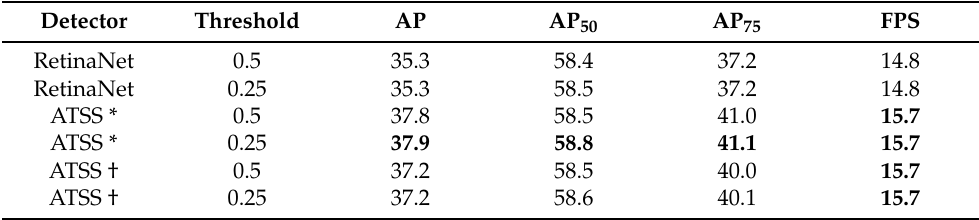
Table 5. Comparison of RetinaNet with and without ATSS. The centerness score prediction is typically applied after filtering low confidence detections. However, the TensorRT NMS has not support for such an operation. Thus, we evaluate both multiplying the centerness score before filtering detections and ignoring the centerness score. Both variants significantly increase the precision compared to not applying ATSS while multiplying the centerness score with the class score prediction before the filtering procedure shows a higher precision. To accommodate the lower scores, we reduce the score threshold which slightly increases the precision. All variants with ATSS significantly increase the FPS since ATSS uses only 1 anchor instead of 9. Detector